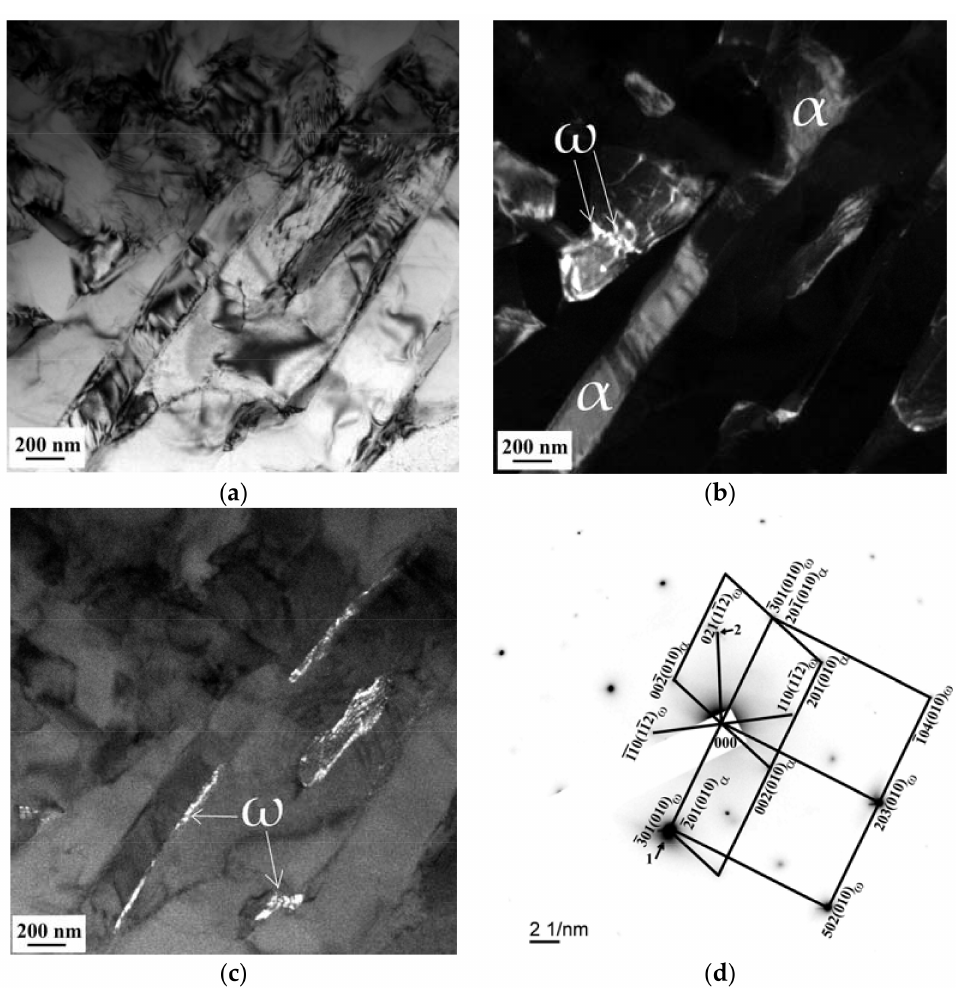
Figure 4. Transmission electron microscopy (TEM) bright- ( a ) and dark-field images ( b , c ) and associated selected area electron diffraction (SAED) pattern ( d ) of the microstructure of EBM titanium Ti-6Al-4V parts; b—the dark-field image obtained with 201 α -Ti and 301 ω -Ti reflections (marked by an arrow 1); c—the dark-field image obtained with 021 ω -Ti reflection (marked by an arrow